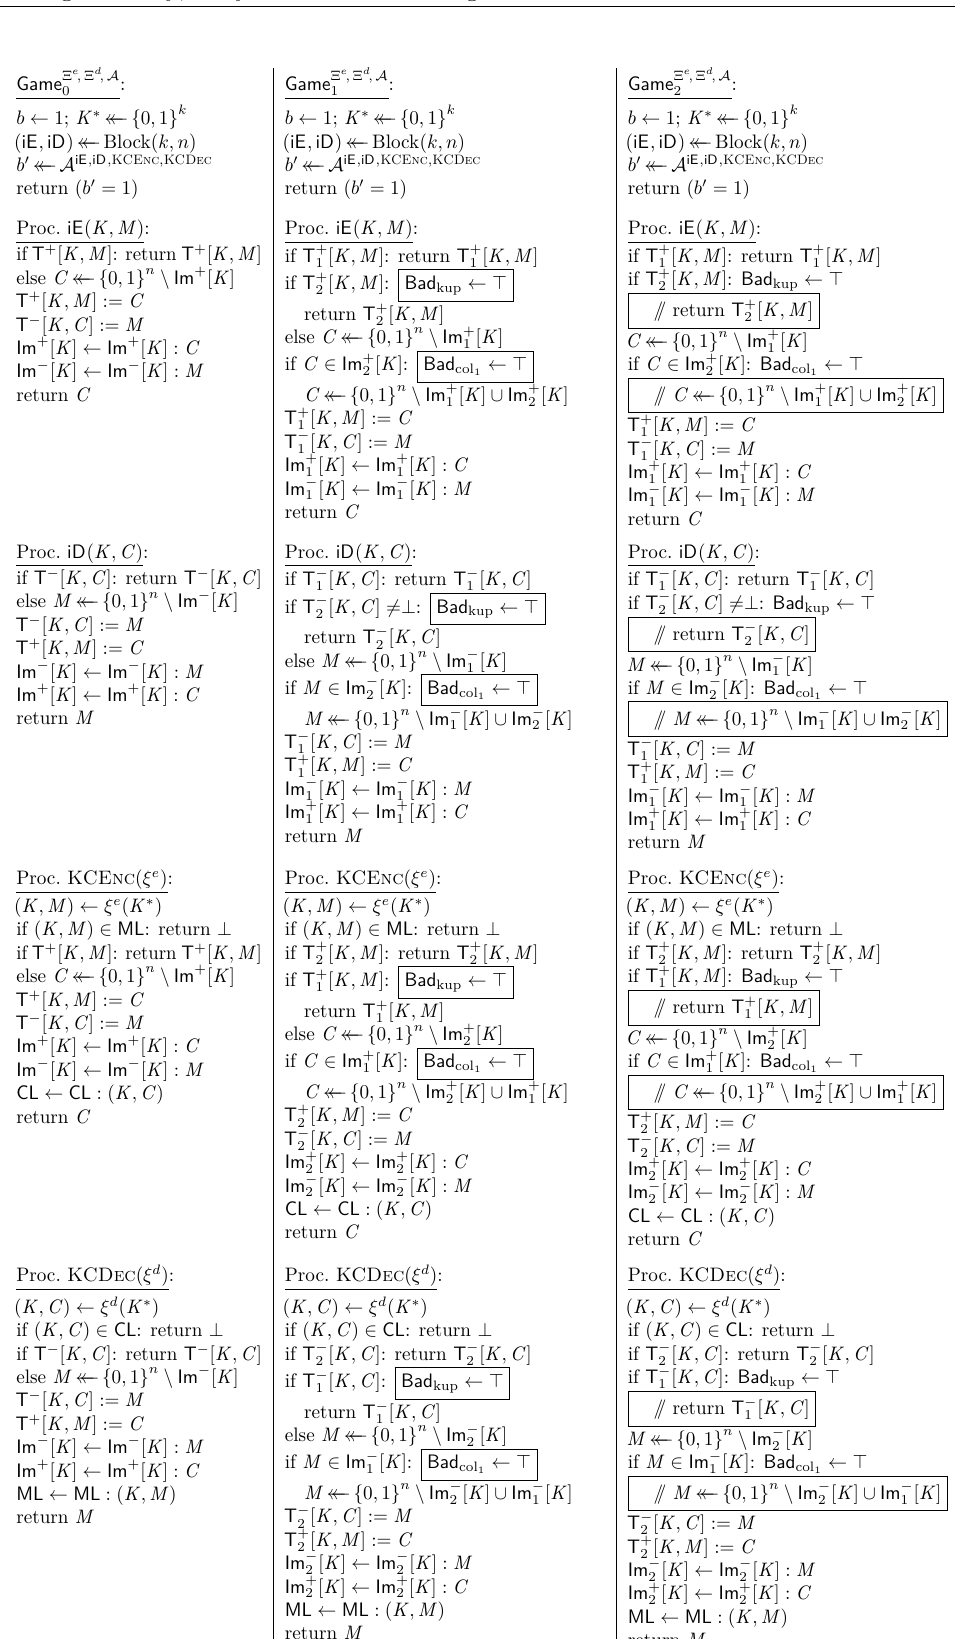
Figure 5: Game 0 , Game 1 , and Game 2